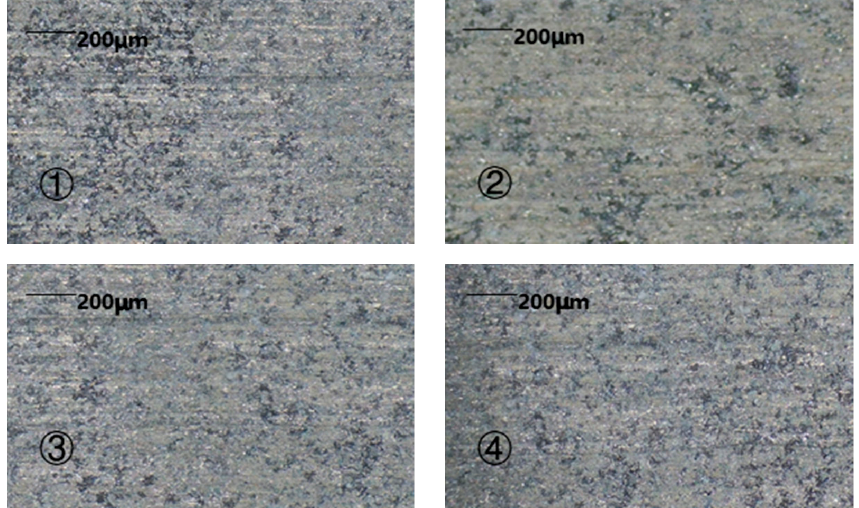
Figure 11. Resulting morphology for different feed rate values: ① 2 mm/min; ② 3 mm/min; ③ 4 mm/min; ④ 5 mm/min.